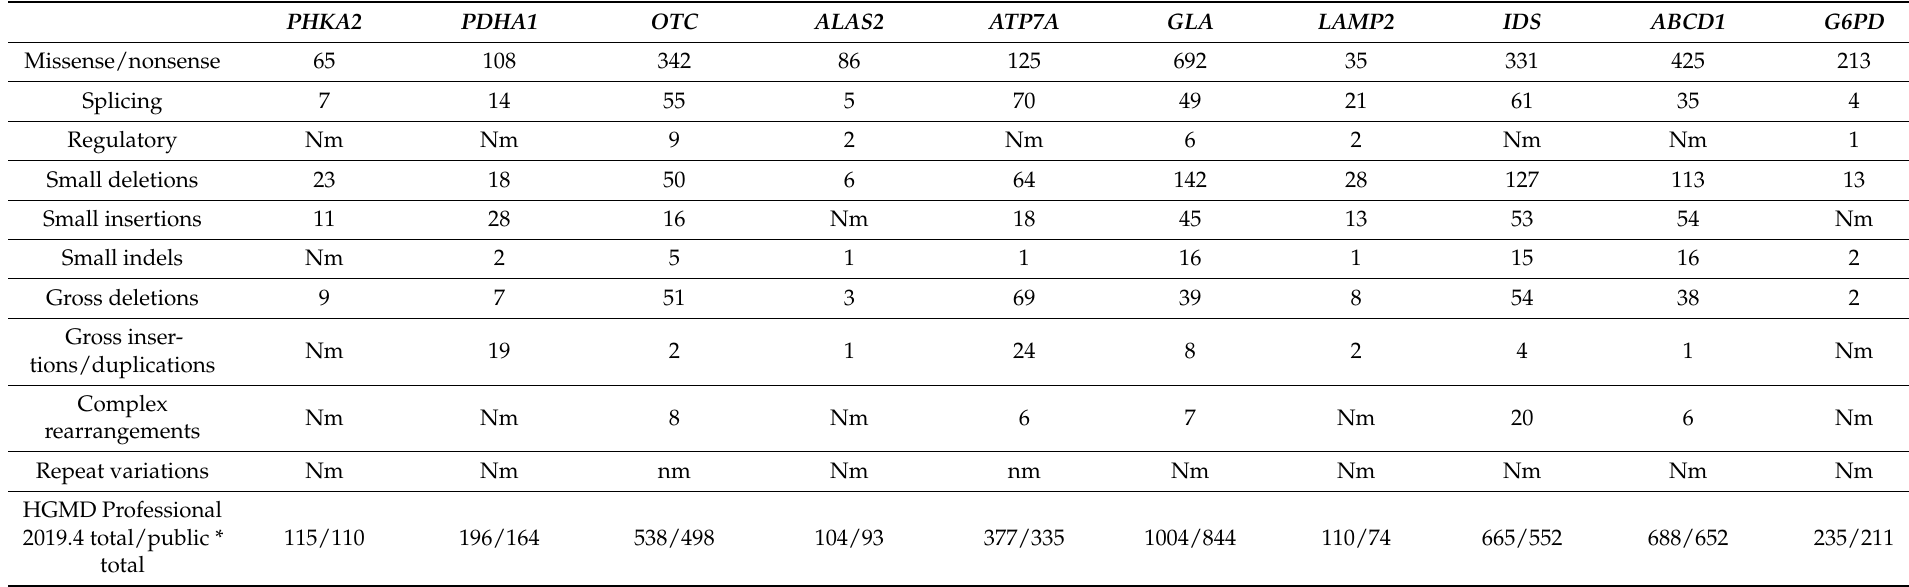
Table 2. Number of mutations in genes associated with the disorders presented in this review described in The Human Gene Mutation Database